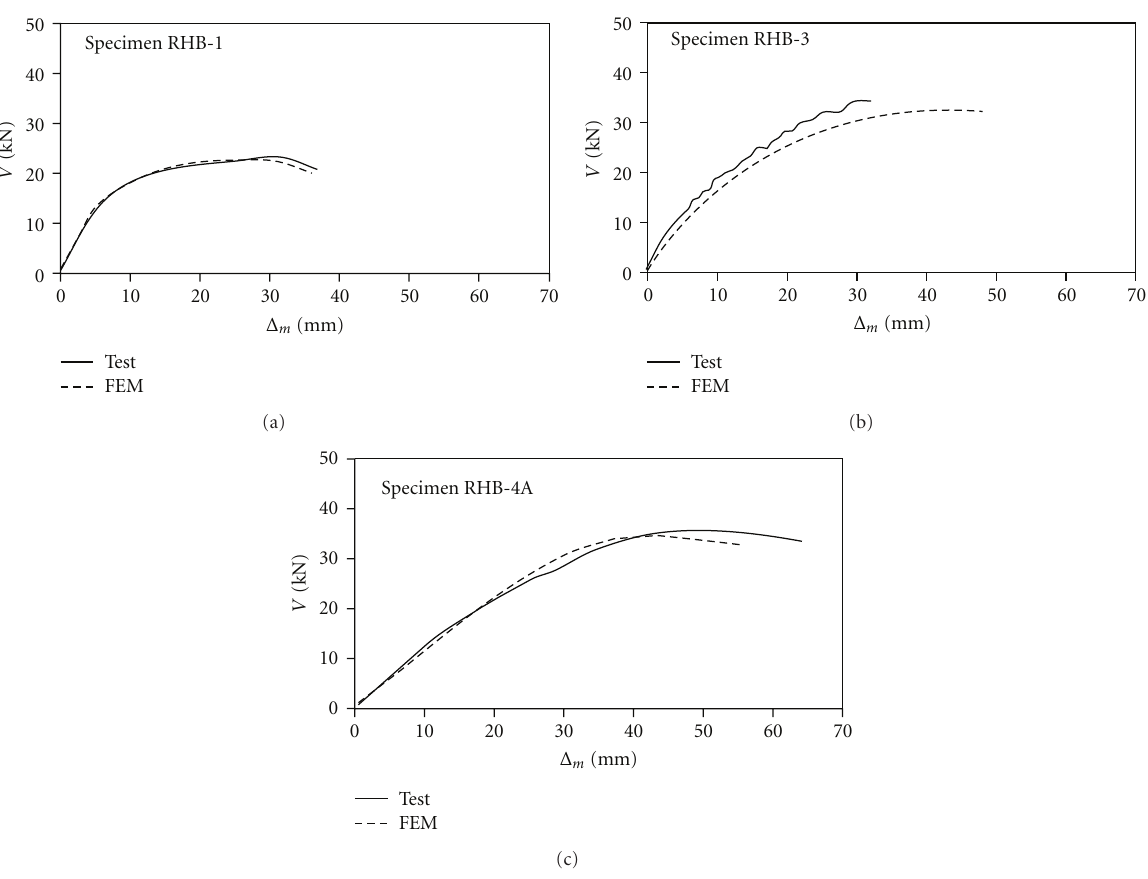
Figure 16: Comparison of load-deflection curves computed from FEM with those measured from physical tests: (a) Specimen RHB-1, (b) Specimen RHB-3, and (c) Specimen